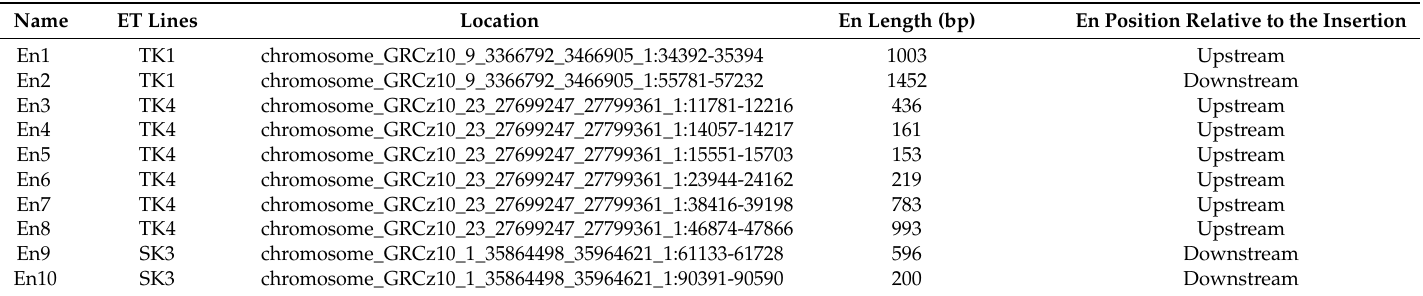
Table 2. The detailed information of 10